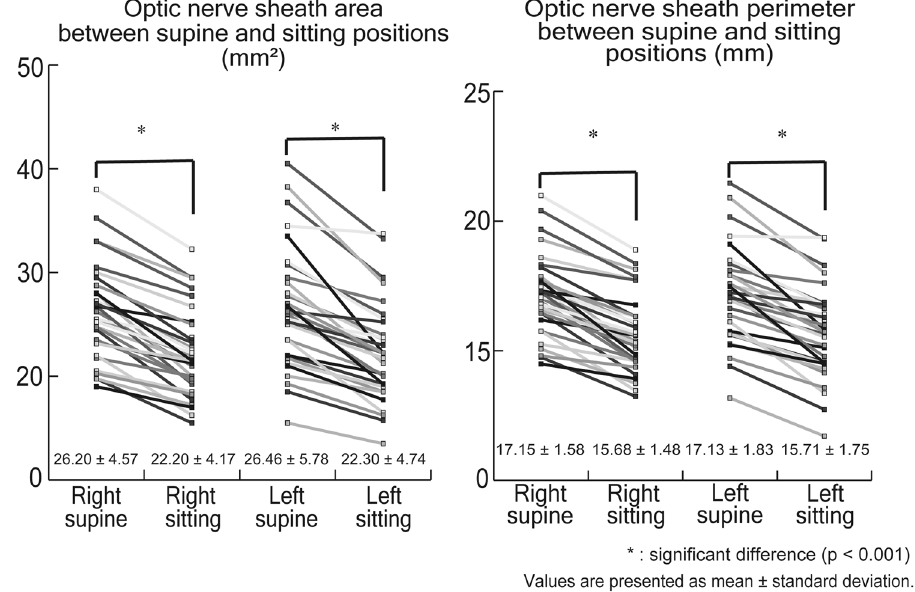
Figure 6. The figure shows ONSA and ONSP in supine and sitting position. Both ONSA and ONSP decreased in sitting position compared with supine position significantly (p <